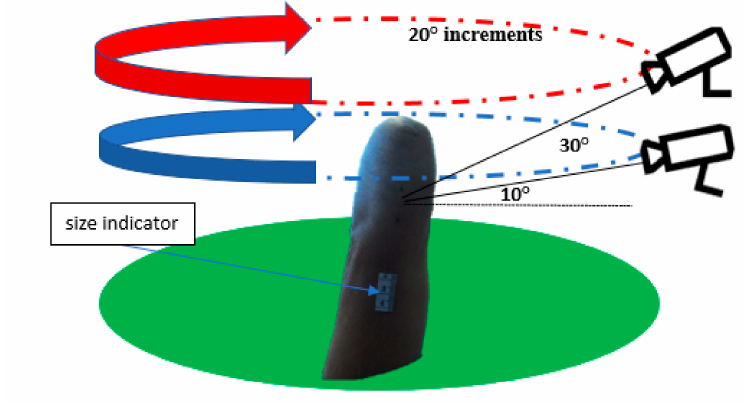
Figure 2. Illustration of images retrieval used in this